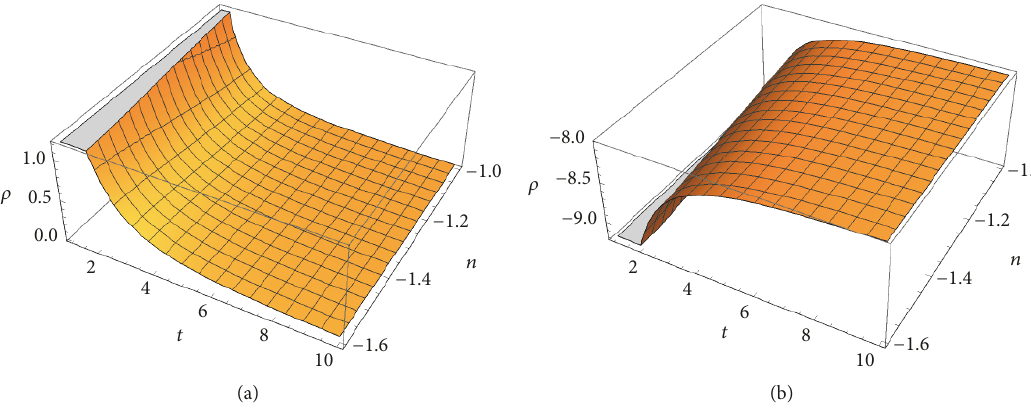
Figure 3: Behaviour of 𝜌 for subrelativistic universe.